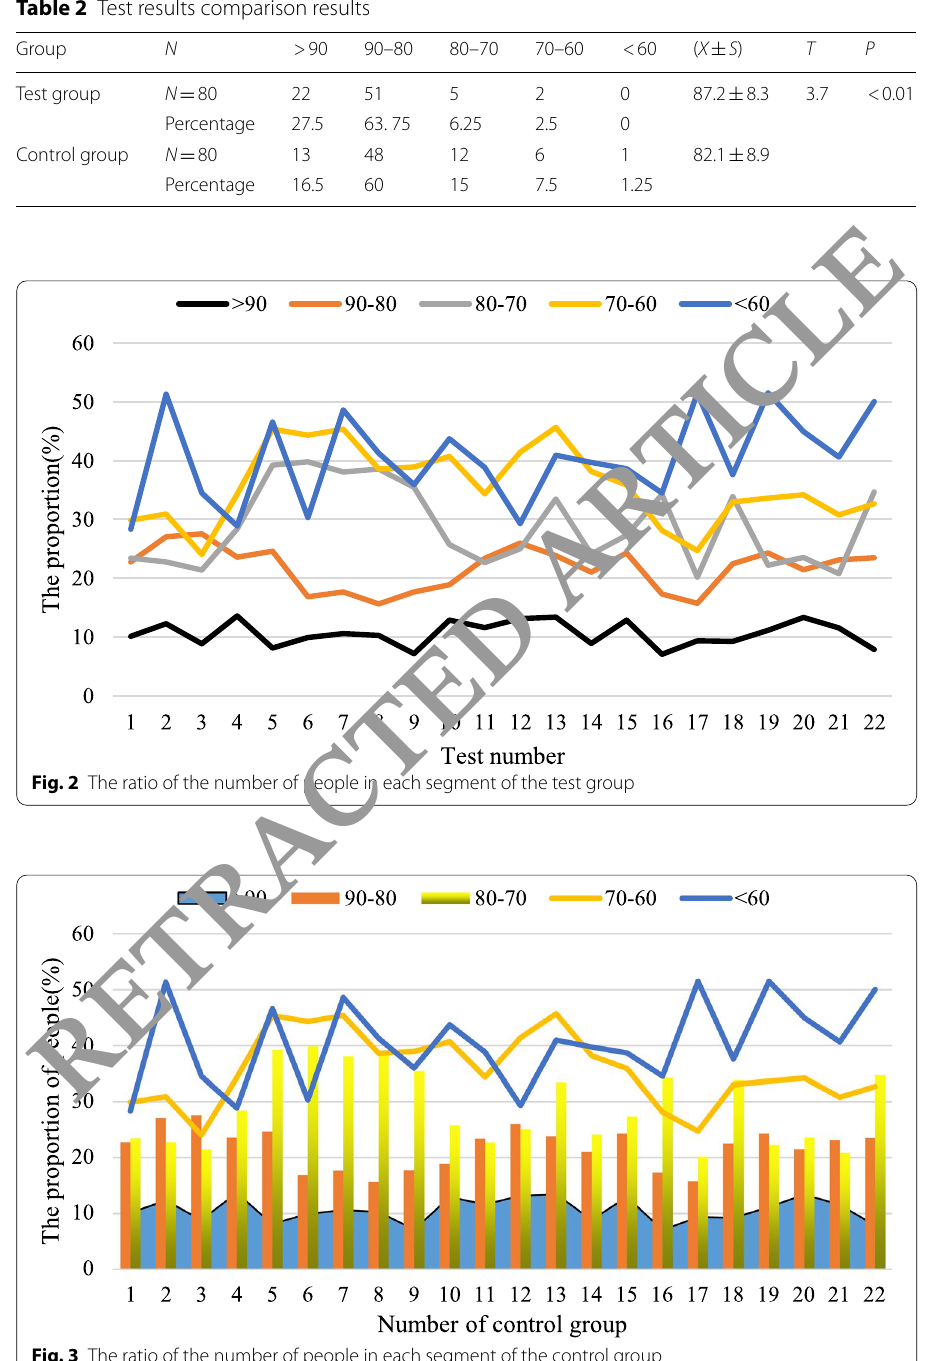
Fig. 3 The ratio of the number of people in each segment of the control